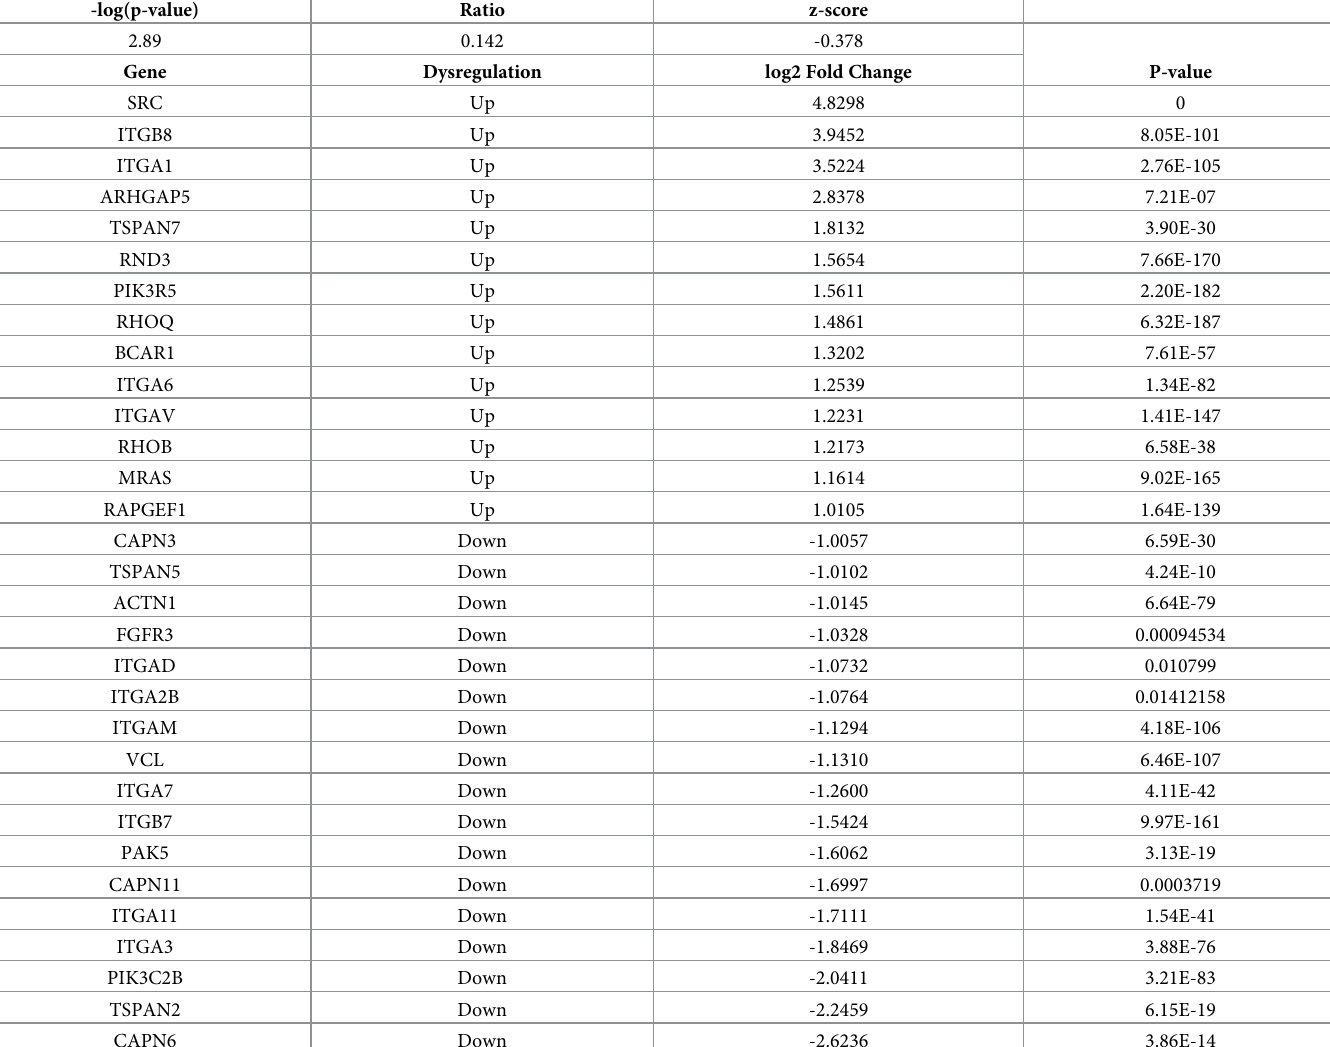
Table 4. The DEGs of Integrin signaling. According to IPA analysis on integrin pathway, the–log(p-value) is 2.89. The ratio refers to number of the DEGs divided by total number of genes in the pathway, Z-score shows the likeliness of pathway activation. The value of -0.378 meant the pathway was downregulated.